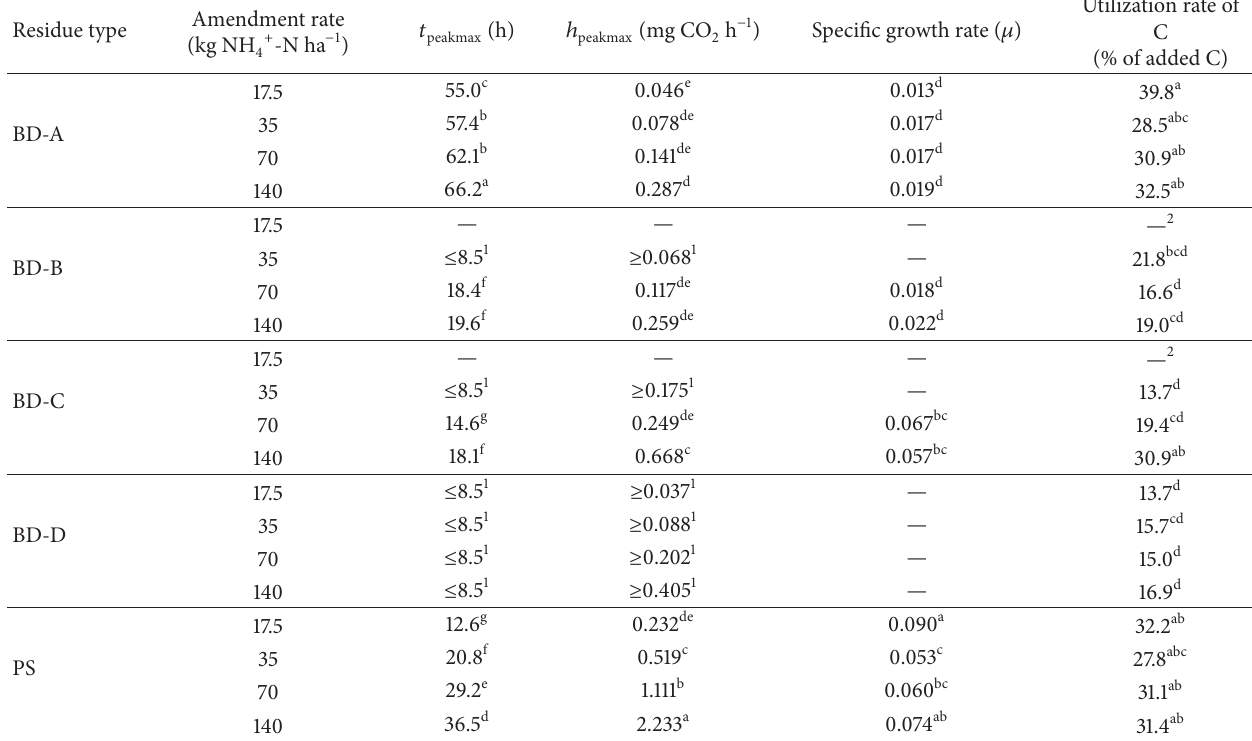
Table 5: Calculated parameters from soil respiration curves after amendment with four types of biogas digestates (BD-A, BD-B, BD-C, and is the time of maximum respiration activity after amendment and the maximum peak height ( ℎ BD-D) and pig slurry (PS). 𝑡 peakmax the respiration rate at that time. Specific growth rate ( 𝜇 ) was calculated according to ISO/DIS 17155 (i.e., on a log is the cumulative respired C during the 12 days of incubation. Values not sharing the same letters (a–e) are statistical significantly different ( 𝑃 < 0.05).